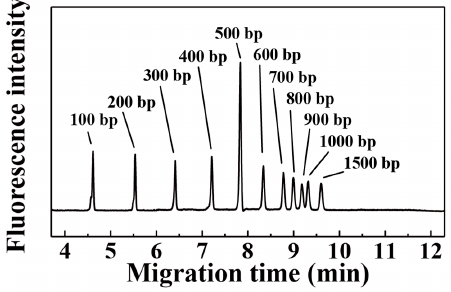
Figure 3. Separation of DNA samples by CGE using a capillary coated with 100 mol % polyacrylamide.